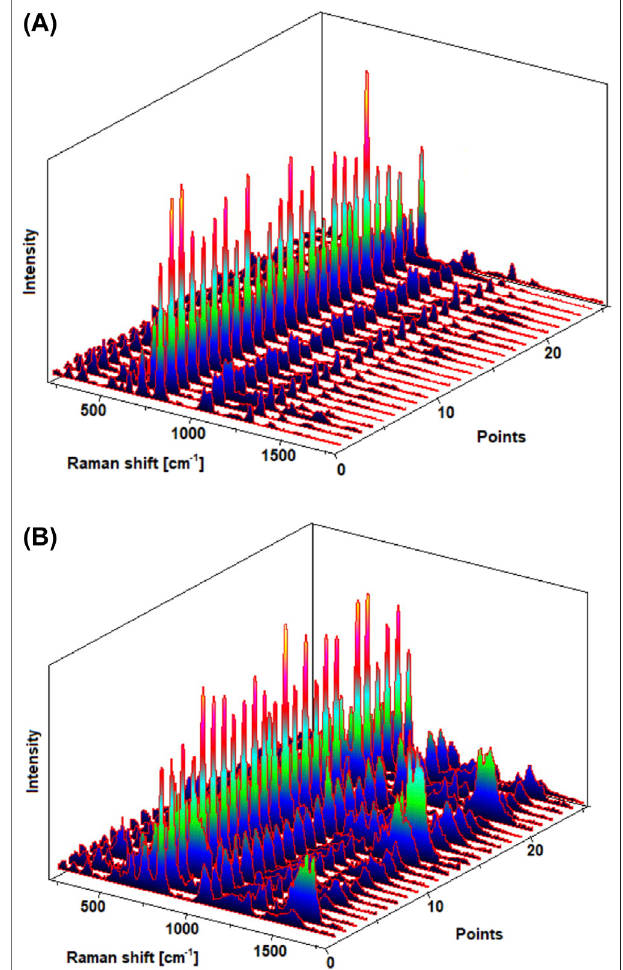
FIGURE 8 | 3D display of series of SERS spectra (excitation line 632.8 nm, 3 × 10 s acquisition time for each spectrum, laser power on the sample around 0.75 mW) of MES on Ag/Fe 3 O 4 adsorbed for 12 h (A) and 1 h (B) , collected from various locations of the sample (listed as points). For part (B) the characteristic “ carbon fl uctuations ” are clearly visible in the spectral range above 1300 cm − 1